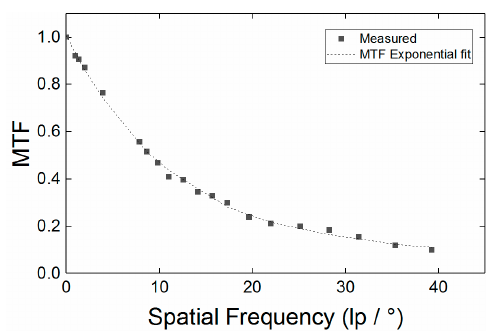
Figure 11. Plot of the modulation transfer function vs. spatial frequency. Following our definition of FOV by analogy to radiation thermometry, the minimum spatial frequency for a temperature measurement at which MTF is ≥ 95% is 0.74 lp mm − 1 . This corresponds to an object approximately 10 mm wide at a working distance of 450 mm. Our temperature MFOV is, therefore, 45:1. An exponential decay with an offset was used to fit these data.